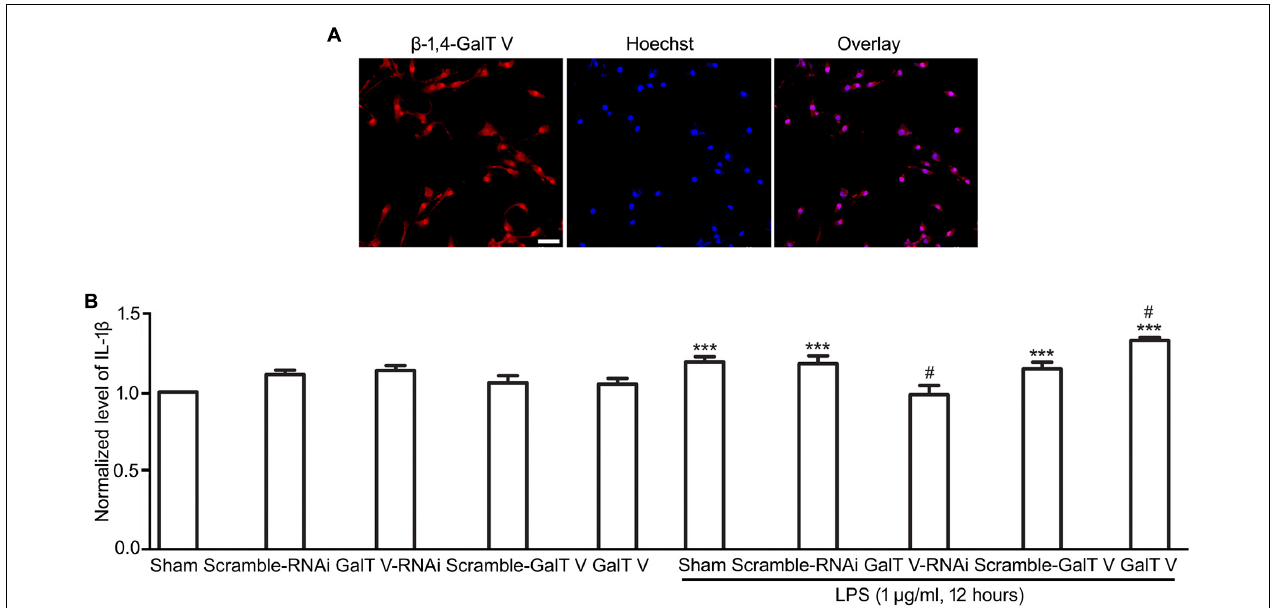
FIGURE 1 | Enhancement of β -1,4-galactosyltransferase V ( β -1, 4-GalT V) on the release of IL-1 β evoked by LPS. β -1, 4-GalT V expressed in HAPI cells (A) ; scale bar, 50 µ m. (B) Quantification of IL-1 β level in supernatants from HAPI cells with designated constructions as indicated were treated with LPS (1 µ g/ml, 12 h). Groups significantly different from non-treated sham group, LPS-treated sham group were marked by asterisks, hashtag, respectively. Data are normalized to the non-treated Sham group, and presented as mean ± SD; n = 3; *** p < 0.001, # p <